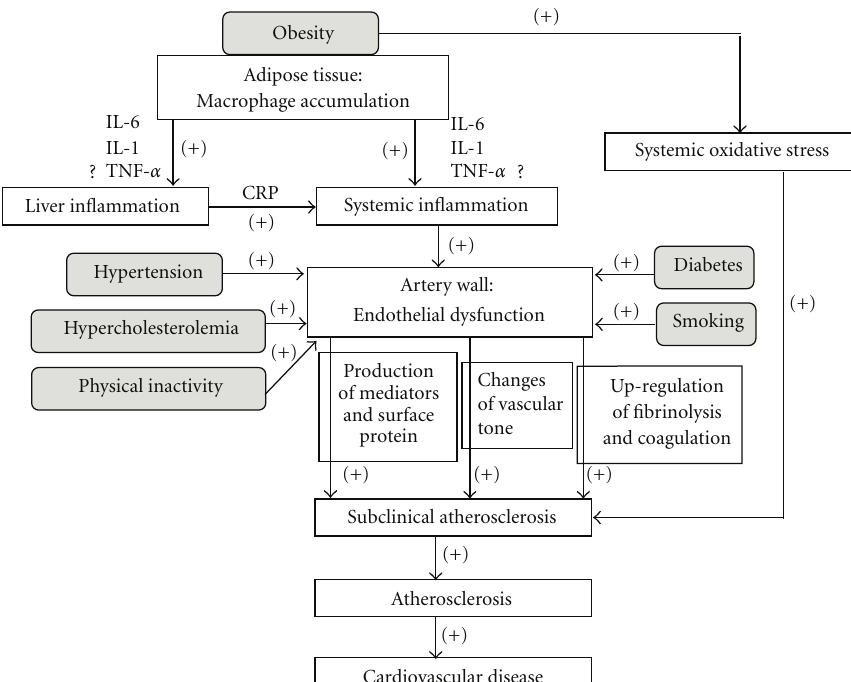
Figure 2: Mechanism of the relationship between inflammation induced by obesity and cardiovascular disease. Gray box shows the traditional cardiovascular disease (CVD) risk factors. The arrow and plus symbols indicate the enhanced courses. Smoking, obesity, hypertension, diabetes, physical inactivity and hypercholesterolemia are established risk factors of CVD. In obese individuals, macrophages first accumulate within the adipose tissue, leading to local inflammation. As the obesity increases, several proinflammatory factors, including IL-1, IL-6 and TNF- α , are produced in the adipose tissue. Macrophage accumulation and the subsequent local inflammation are believed to result in numerous metabolic dysfunctions that typically accompany obesity, including systemic inflammation. Endothelial dysfunction occurs during the early stages of atherosclerosis and is responsible for the pathophysiological changes in subclinical atherosclerosis, which include changes in a variety of mediators, surface proteins, and in autacoids that are involved in vasomotion, coagulation and inflammation. Obesity also can increase systemic oxidative stress independently of blood glucose and diabetes. One of the major events of atherosclerosis is